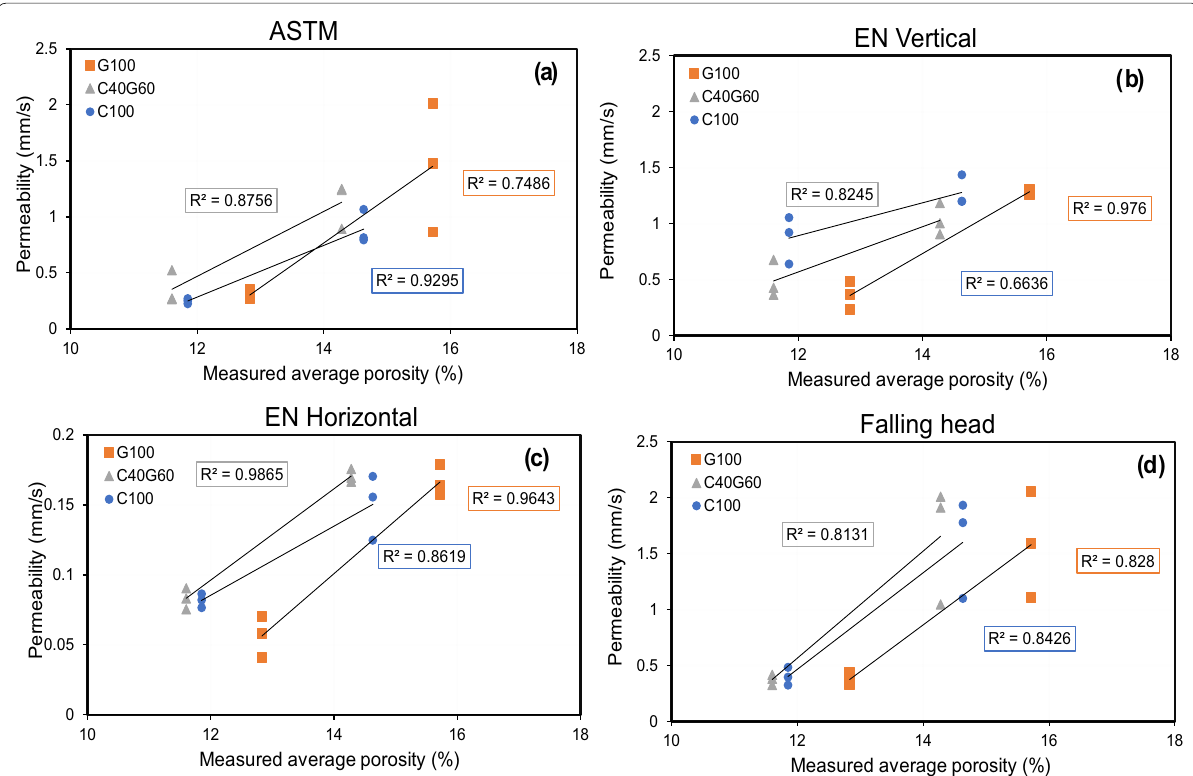
Fig. 14 Relationship between porosity and water permeability using various test methods: a ASTM; b EN vertical; c EN horizontal; and d falling